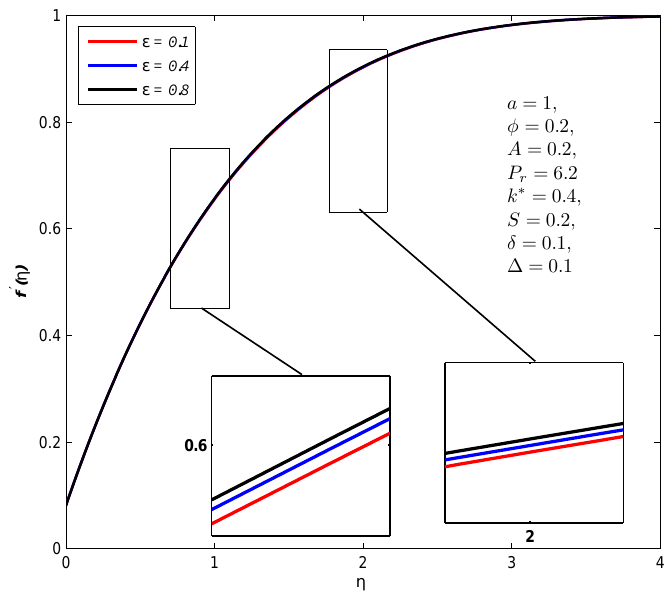
Figure 9. Velocity f (cid:48) ( η ) profiles for different values of thermal conductivity parameter (cid:101) .